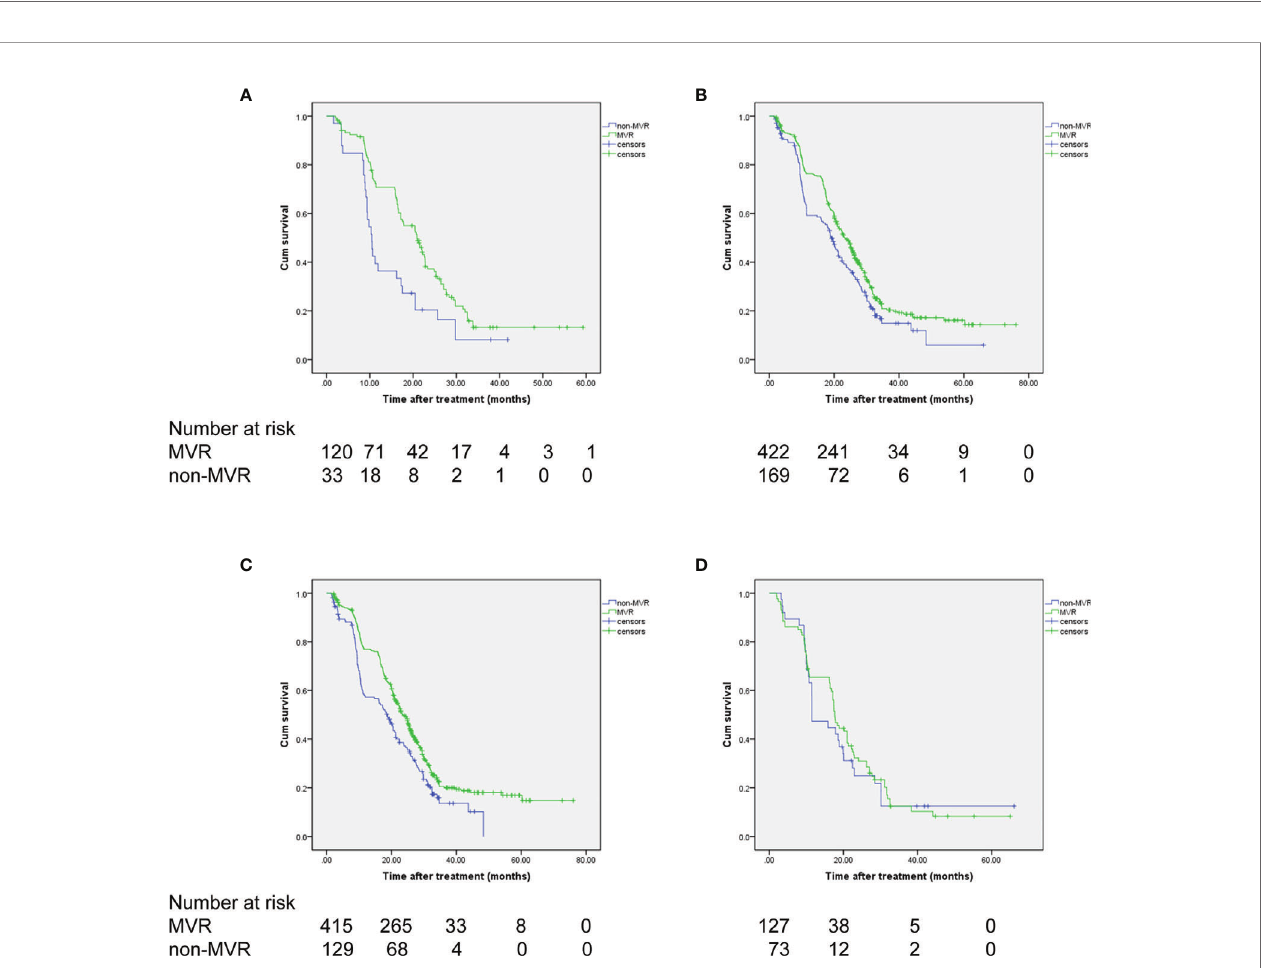
FIGURE 3 | OS of the patients achieving VR based on (A, B) splenomegaly status and (C, D) up-to-seven criteria. (A) without splenomegaly, (B) with splenomegaly, (C) within up-to-seven criteria, (D) beyond up-to-seven criteria.